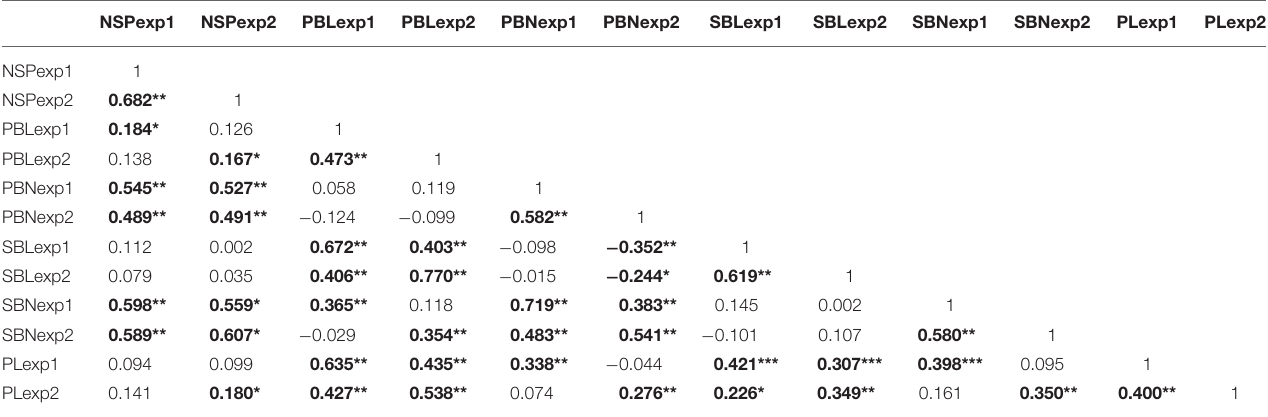
TABLE 3 | Correlation between panicle architecture and number of spikelets per panicle for both experiments. NSPexp1 NSPexp2 PBLexp1 PBLexp2 PBNexp1